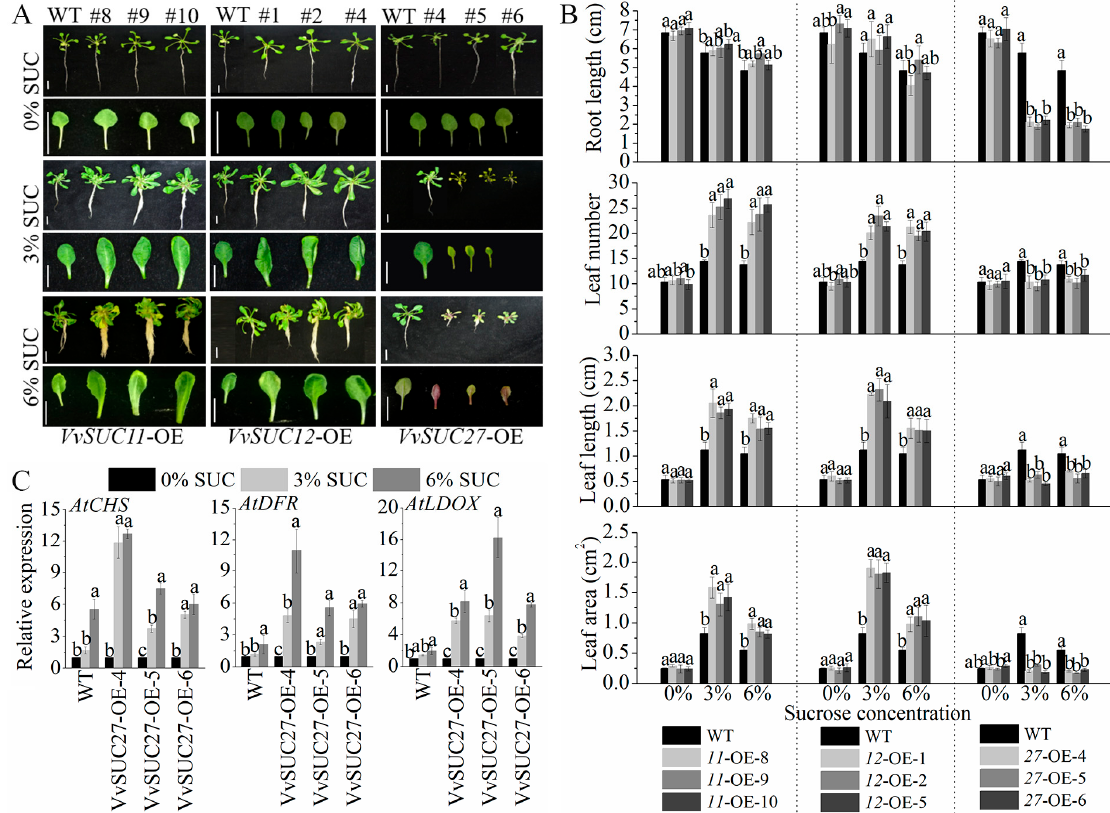
Figure 2. Phenotypes of 4-week-old VvSUC -OE Arabidopsis grown in medium supplemented with di ff erent sucrose concentrations. ( A ) The phenotype di ff erences of whole seedlings and leaves of VvSUC11 -, VvSUC12 -, and VvSUC27 -OE lines, compared with those of WT. Bars = 1 cm. ( B ) The phenotype di ff erences in the root length, leaf number, leaf length, and leaf area between VvSUC -OE lines and WT. Data are expressed as mean ± SD (n = 5). Di ff erent letters indicate significant di ff erences ( P < 0.05) between each VvSUC -OE line and WT at one sucrose concentration, as determined by ANOVA followed by Tukey’s test. ( C ) The expression levels of AtCHS , AtDFR, and AtLDOX in VvSUC -OE grown on MS media supplemented with 0%, 3%, and 6% sucrose. The cDNA from 4-w-old leaves was isolated and tested for the presence of Actin , which served as the internal control for gene expression. Relative gene expression in each VvSUC -OE line was calculated by comparing the expression values from seedlings grown on sucrose-supplemented media with those of the control medium, which was set to one. Data are expressed as mean ± SD (n = 3). Di ff erent letters indicate significant di ff erences ( P < 0.05) among di ff erent sucrose concentrations, as determined by ANOVA followed by Tukey’s test.